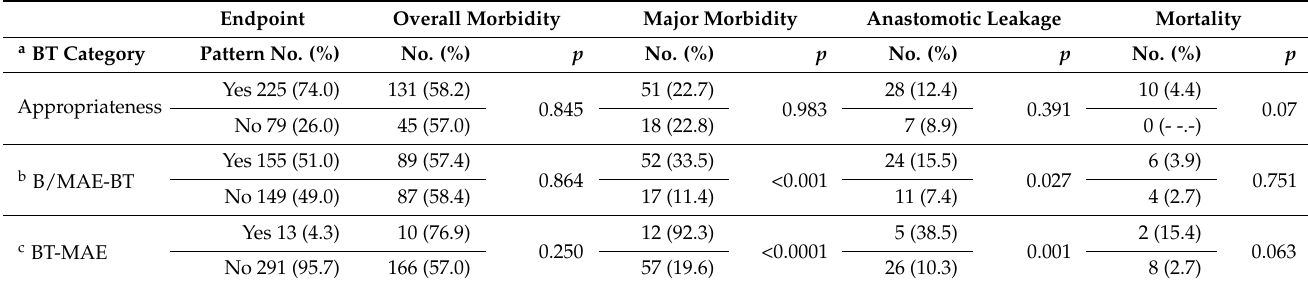
Table 5. Outcome rates according to individual BT categories.